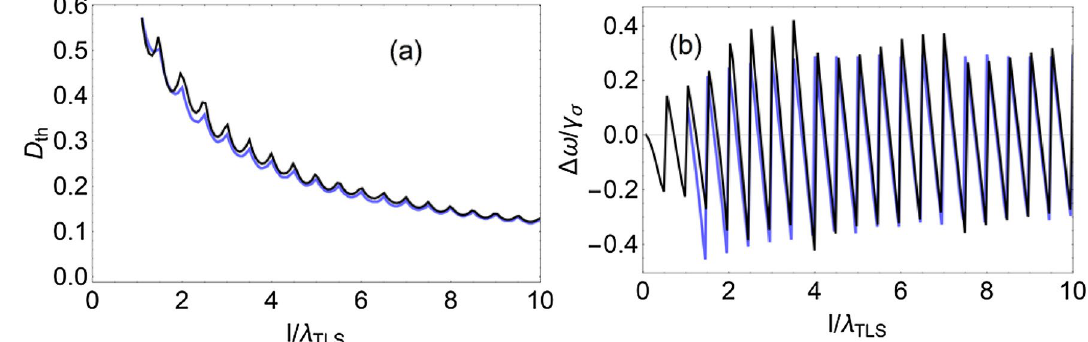
Figure 1. Dependence of the threshold population inversion D th ( a ) and the lasing frequency ω g ( b ) on the length of the active region l at a constant concentration of atoms n . The black line is calculated by the Eq. (4); the blue line is calculated by the Eq. (7). The effective interaction constants between the atoms and the EM mode � α ( x , k ) = � 0 cos ( k x ) and � α ( x , k ) = � 0 sin ( k x ) , where k = ω/ c . The following values of the system parameters are used: � 0 = 10 − 6 ω TLS , γ σ = 5 × 10 − 5 ω TLS , γ D = 1 × 10 − 6 ω TLS , n c = 1.25 × 10 4 (cid:31) − 2 π c /ω TLS = TLS